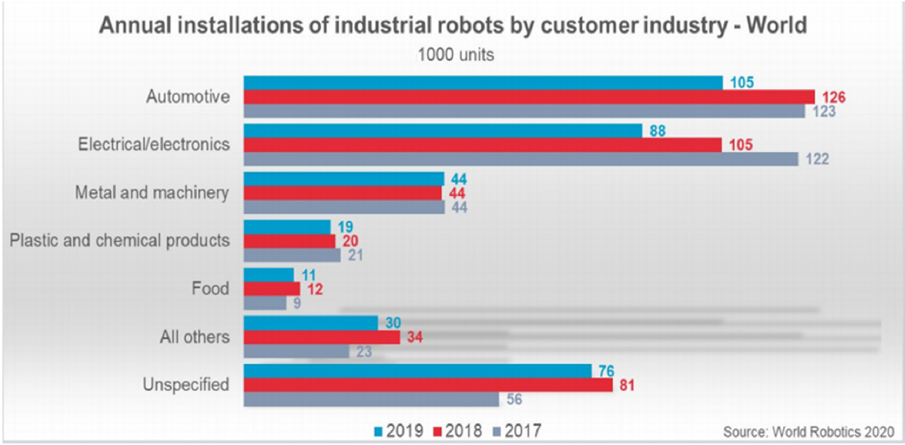
Figure 12. Adoption of robotics in various industries [111].